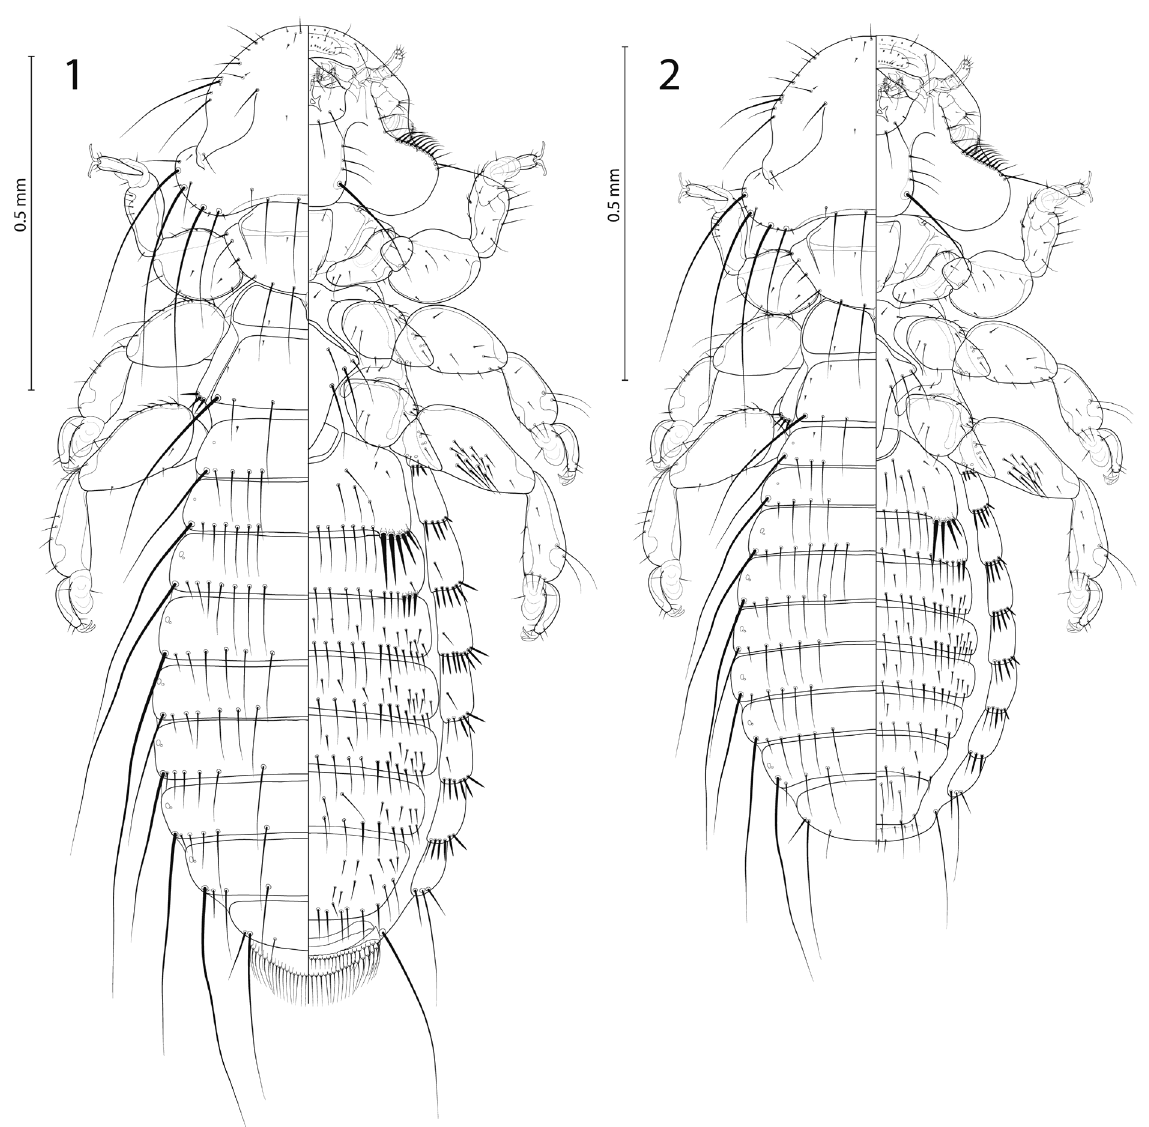
Figs 1–2. Dorso-ventral view of Apomyrsidea klimesi (Sychra in Sychra et al. , 2006) gen. et comb. nov. (CR15). 1 . ♀. 2 .